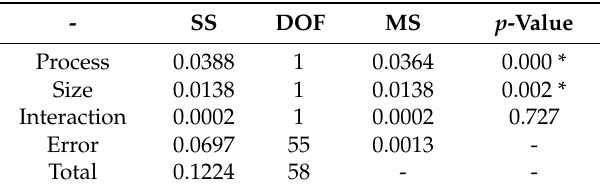
Table 4. ANOVA analysis to assess the influence of size and process on the VHCF strength. Stars denote significant factors.